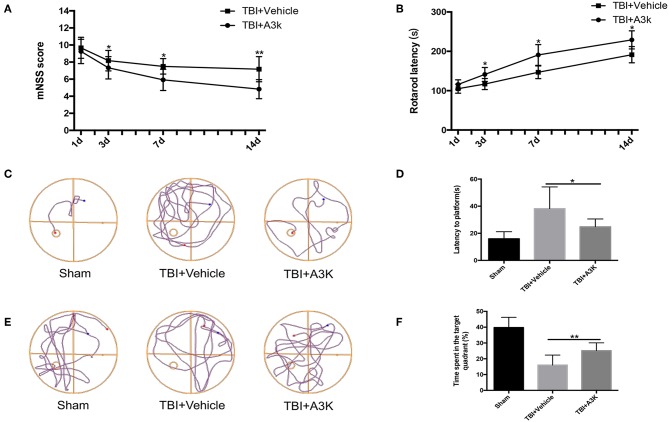
Serpina3k improved neurological function in mice following TBI. mNSS (A) and rotarod test results (B) at 1, 3, 7, and 14 days post-TBI in the TBI+vehicle and TBI+A3K groups. Representative traces (C,E), and quantified time of first arrival at the platform (D) and percentage of time spent in the target (platform) quadrant (F) at 19 days after TBI in the sham, TBI+vehicle, and TBI+A3K groups. Data represent the mean ± SD (n = 12 per group). *P <0.05, **P <0.01, TBI+A3K group vs. TBI+vehicle group.